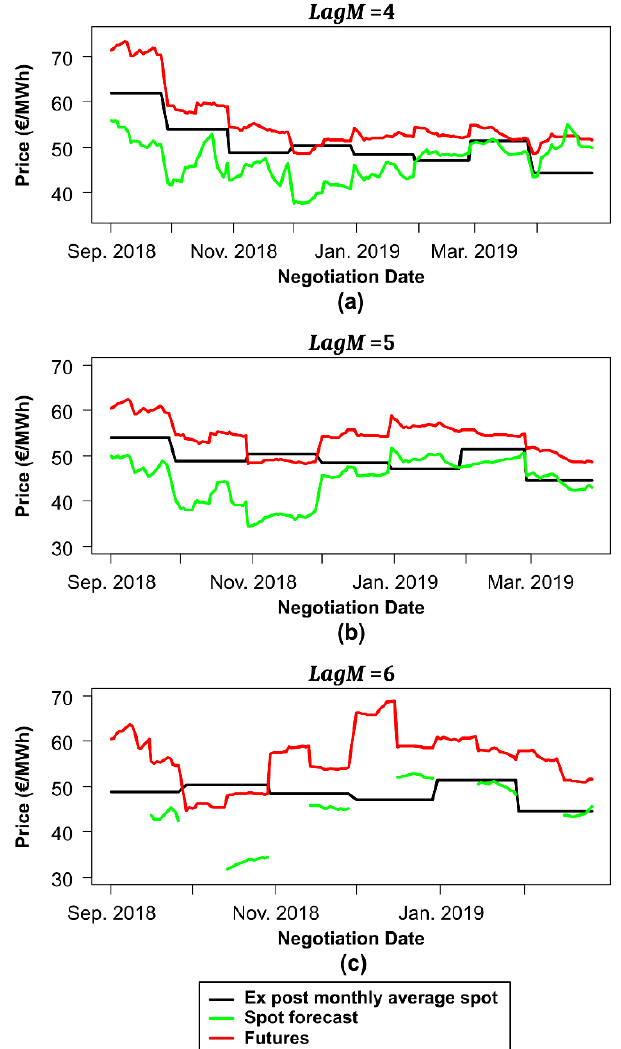
Figure 3. Futures, spot forecast and ex post monthly average prices for the delivery months in the testing period for different maturity ( LagM ) values: (a) for LagM = 4, (b) for LagM = 5 and (c) for LagM = 6.